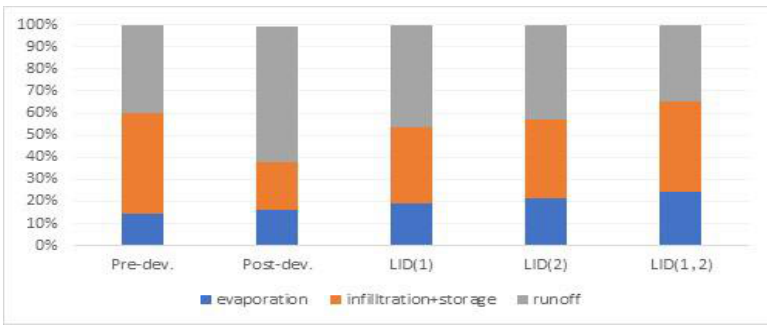
Figure 9. Evaporation, infiltration and storage, and runoff rates.